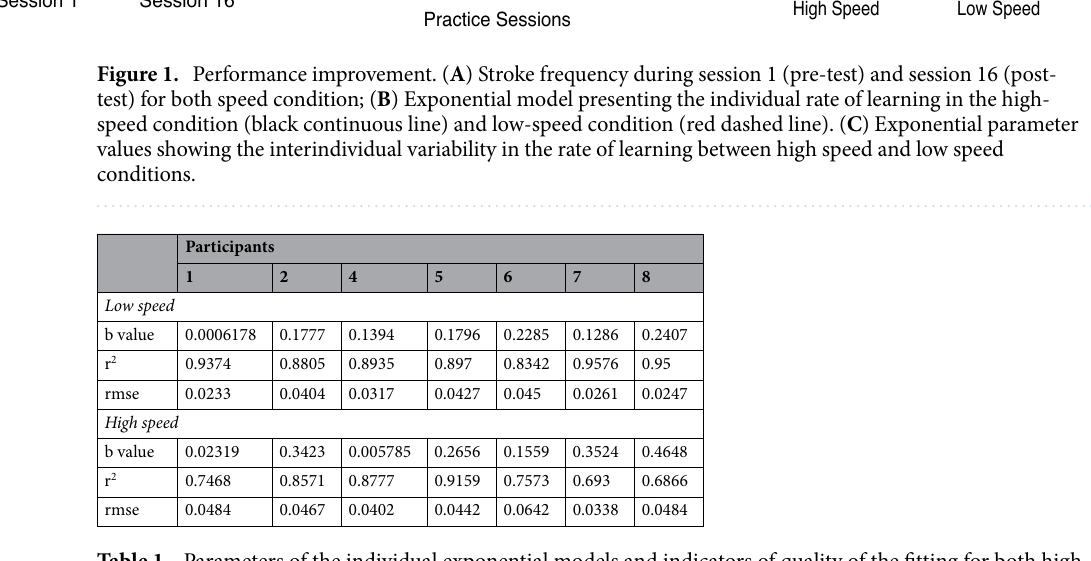
Table 1. Parameters of the individual exponential models and indicators of quality of the fitting for both high speed and low speed